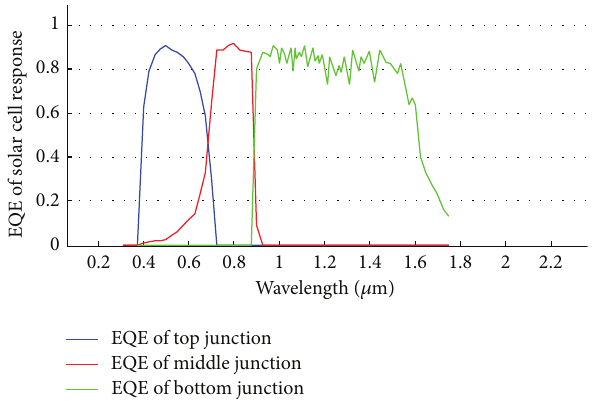
Figure 7: The dependence of refractive index of silicone on temperature: 𝐾 = −3.4𝑒 − 4 ∘ C −1